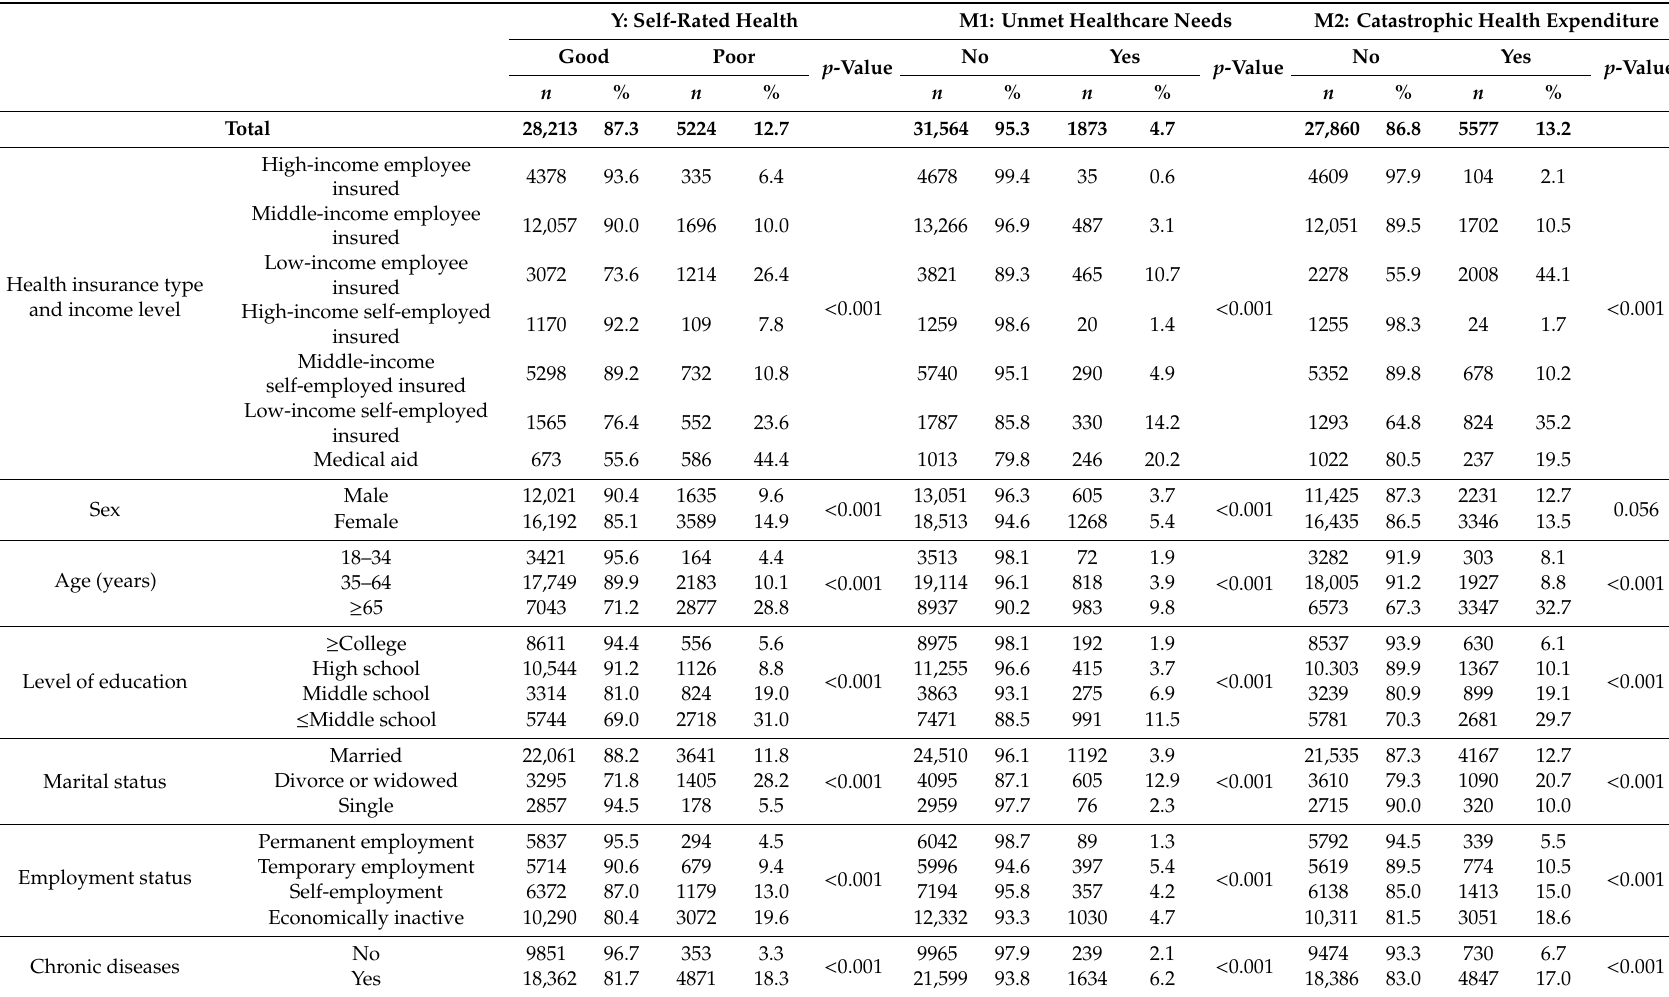
Table 2. General characteristics by self-reported health, unmet healthcare needs, and catastrophic health